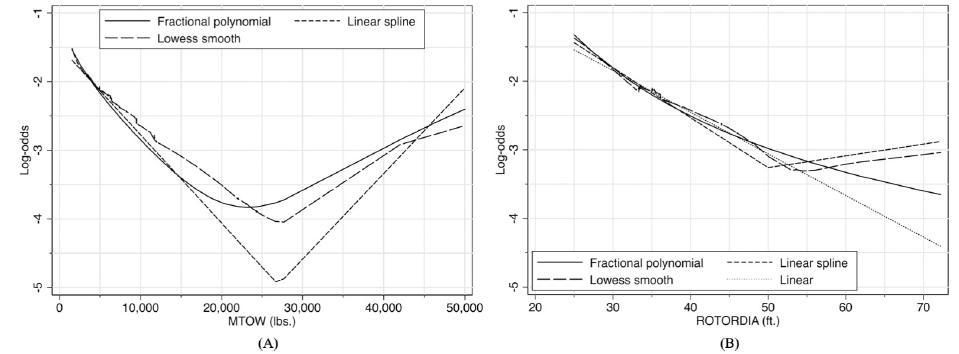
Fig 2. The examination of linearity assumption in the logit for continuous covariate among turboshaft helicopters. (A) two-term fractional polynomial (powers .5 and 1), linear spline with one knot at 27,000 lbs (12,250 kg), and lowess smooth for MTOW; (B) one-term fractional polynomial (power -2), linear spline with one knot at 50 ft (15.24 m), and lowess smooth for rotor diameter.